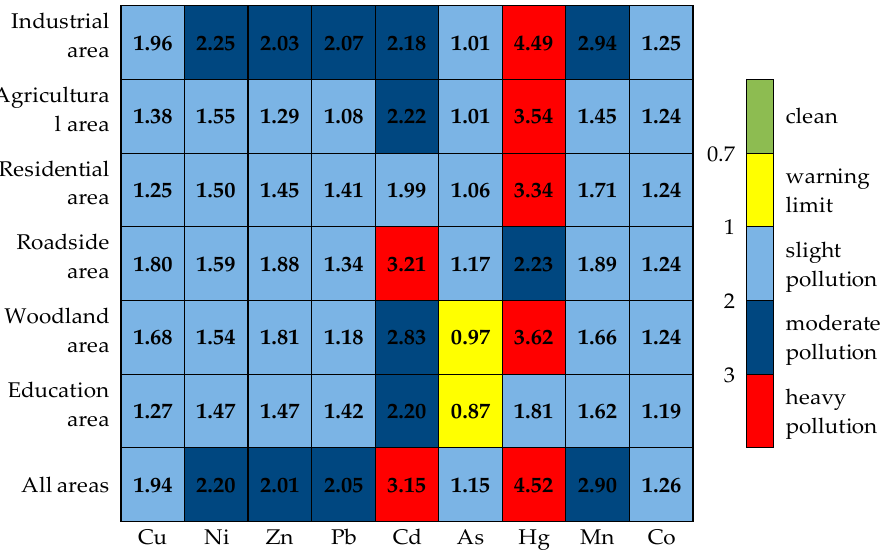
Figure 4. The Nemerow pollution index (NPI) values for the 9 heavy metals in the six functional areas and all areas.